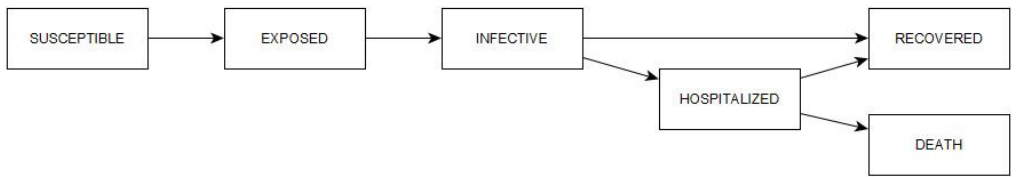
Figure 14. SEIHRD compartment model diagram; it is a SEIRD model adding the hospitalized compartment.